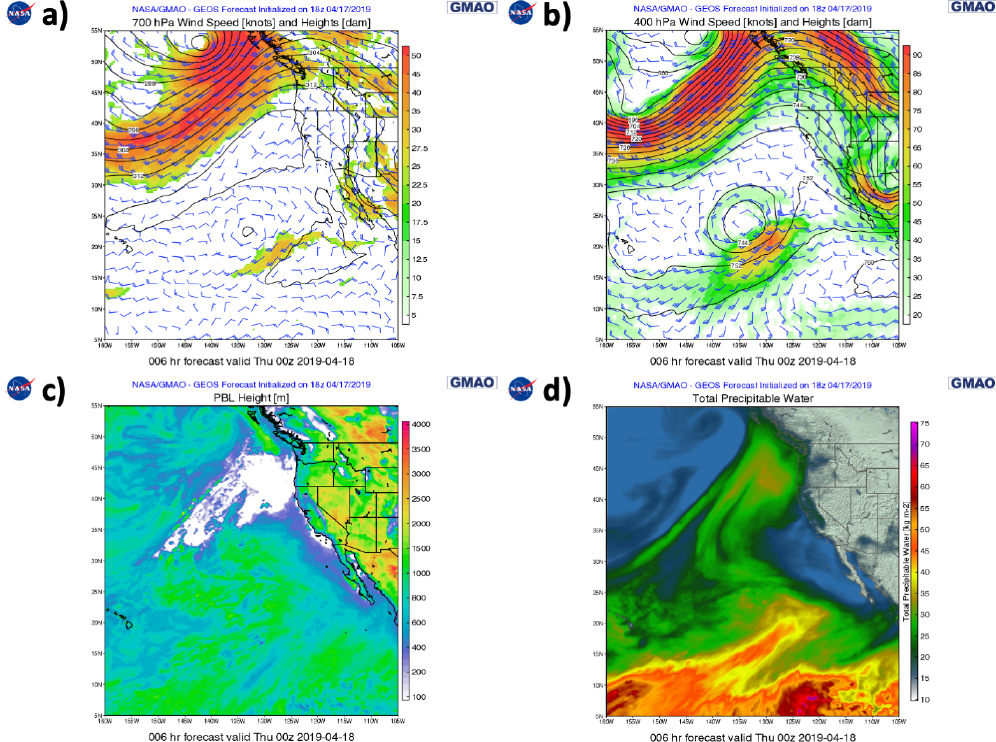
Figure 2. NASA GMAO GEOS-5 6h forecast of (a) 700hPa wind, (b) 400hPa wind, (c) PBL height, and (d) total precipitable water valid at 00:00UTC on 18 April